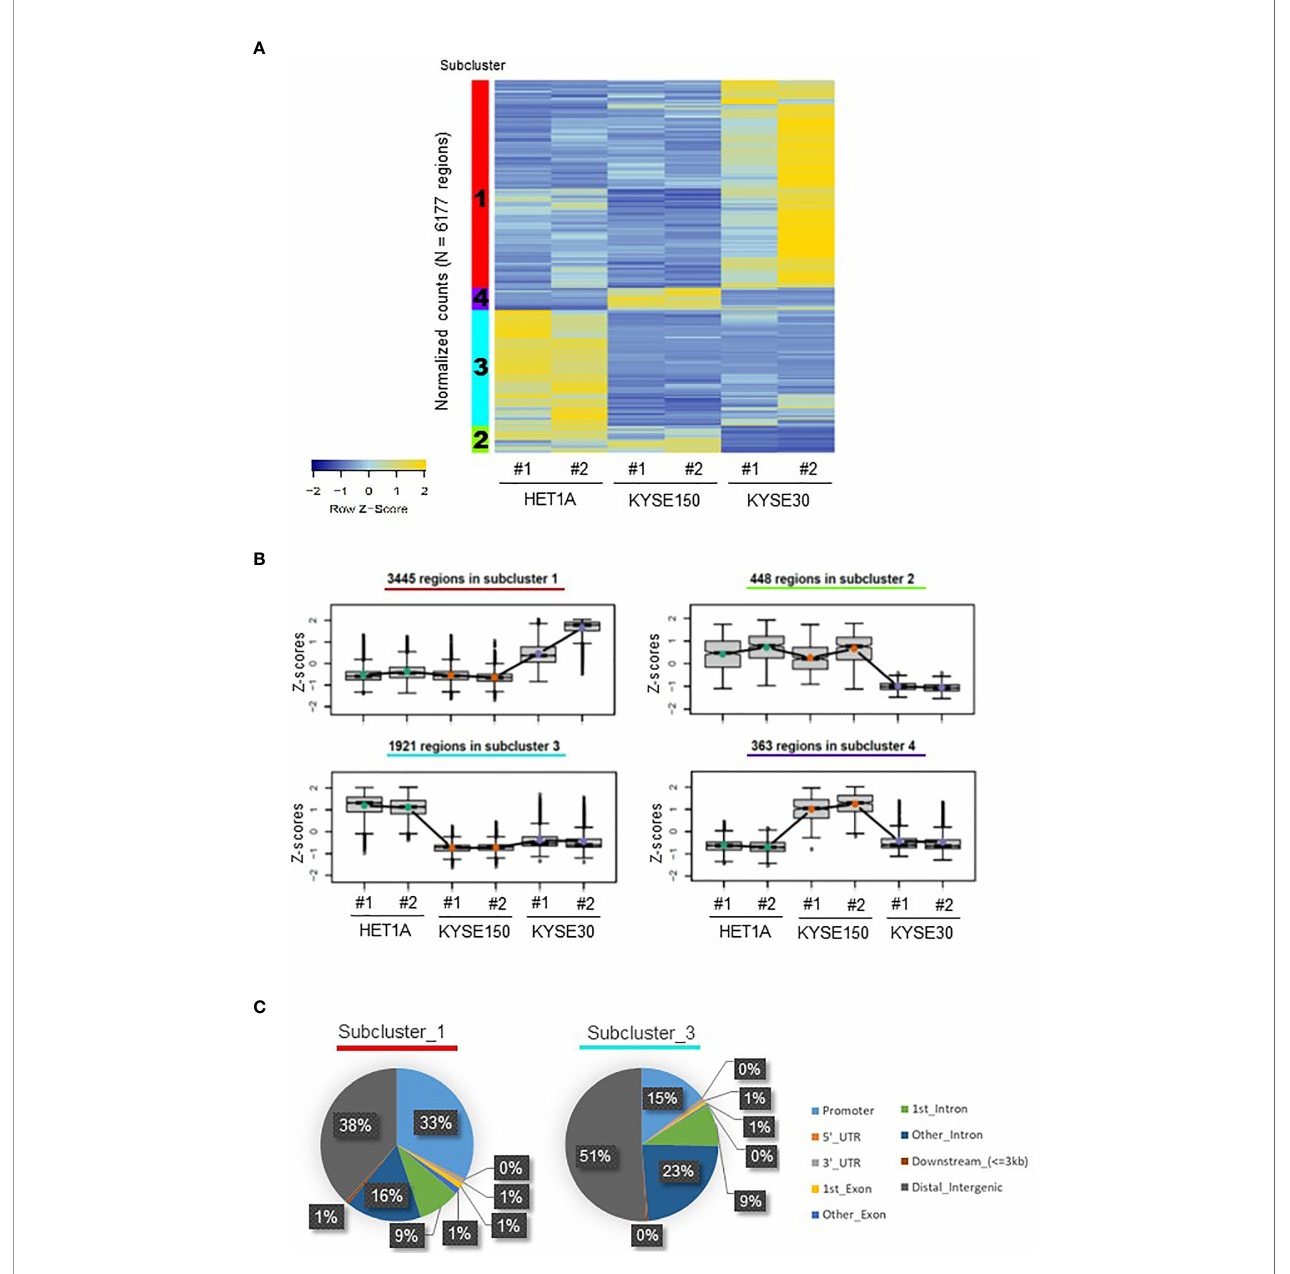
FIGURE 1 | Distribution of ATAC-seq peaks in HET-1A, KYSE-150, and KYSE-30 cells. (A) A heatmap of differentially accessible chromatin regions in each sample, hierarchically clustered into four subclusters of hyper- or hypo-accessible regions among cell lines. The subcluster numbers are shown in the left color-coded columns. (B) Different trends of chromatin accessibility in total 6,177 regions among cell lines. The number of annotated regions in each subcluster is provided. (C) ATAC-seq peaks in subclusters 1 and 3 were differently distributed in the regulatory and non-regulatory genomic regions. Decimal numbers were